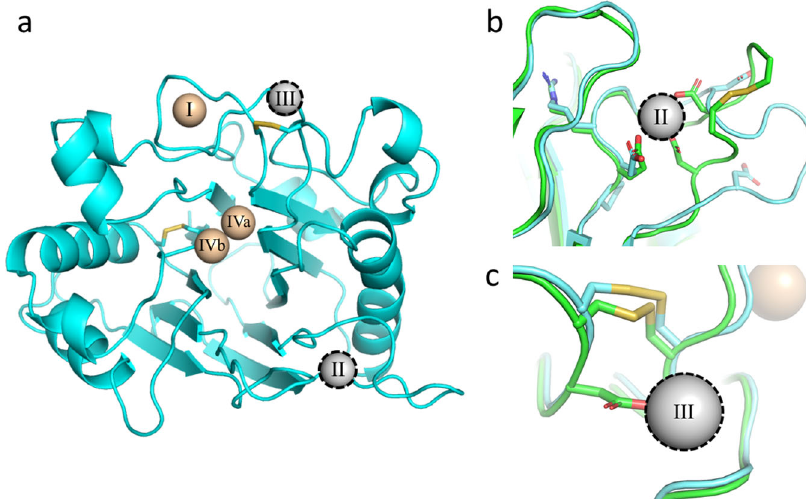
Fig. 3 Dnase1L3 lacks structural divalent cations present in Dnase1. a An overview of the divalent cations previously observed in the Dnase1 family superimposed onto the Dnase1L3 structure 10,24 . Metal ions colored tan were observed in the Dnase1L3 crystal structure. The outlined metal ions in grey are absent in Dnase1L3, but previously observed in Dnase1. b View of missing structural divalent cation site 'II', observed in previous Dnase1 crystal structures 24 . Dnase1L3 is missing a disul fi de bridge that stabilizes the loop structure of site 'II'. c View of missing structural divalent cation site 'III', observed in previous Dnase1 (green) crystal structures 24 . The primary coordinating residue in Dnase1, Asp-172, is a Gly-193 in Dnase1L3 (blue).